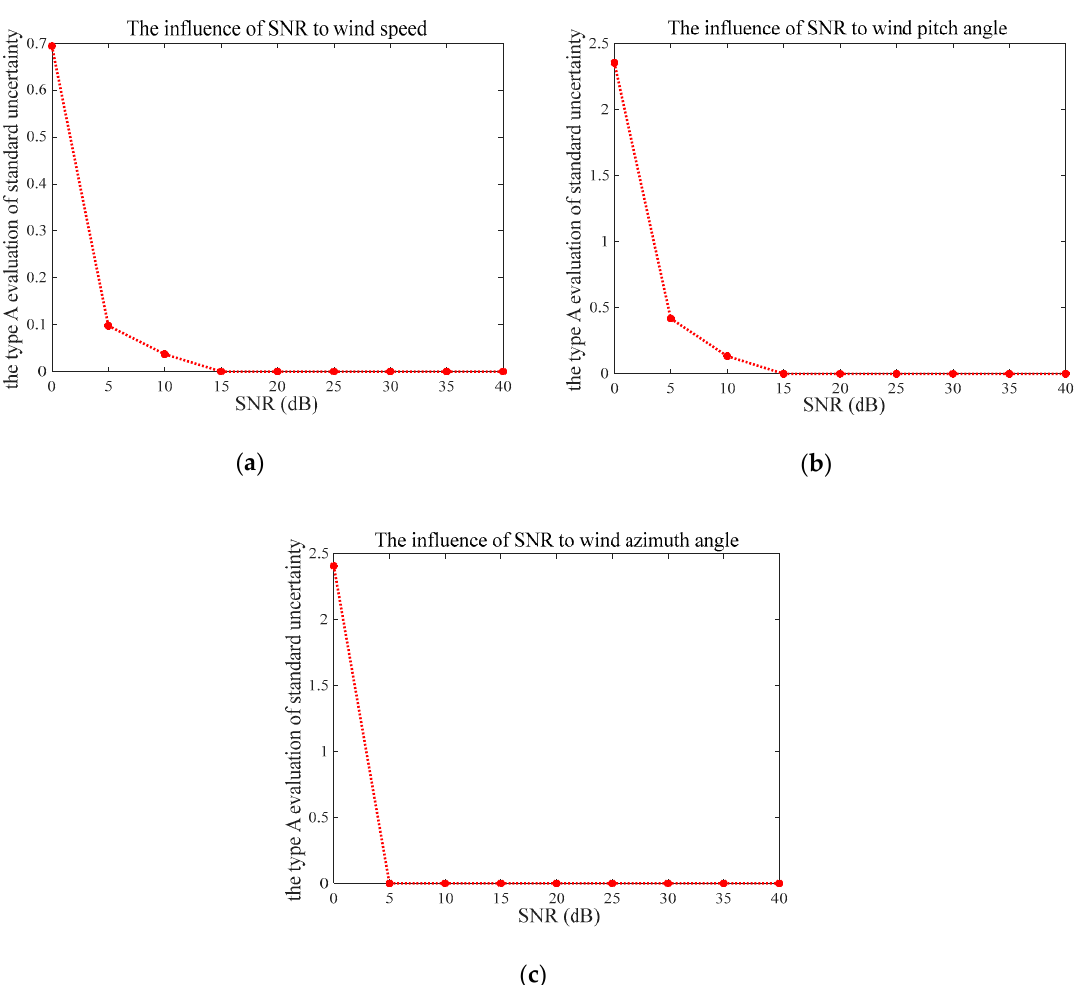
Figure 4. The type A evaluation of standard uncertainty of the results under different SNRs: ( a ) Measurement uncertainty of the wind speed, ( b ) measurement uncertainty of the wind pitch angle, and ( c ) measurement uncertainty of the wind azimuth angle.